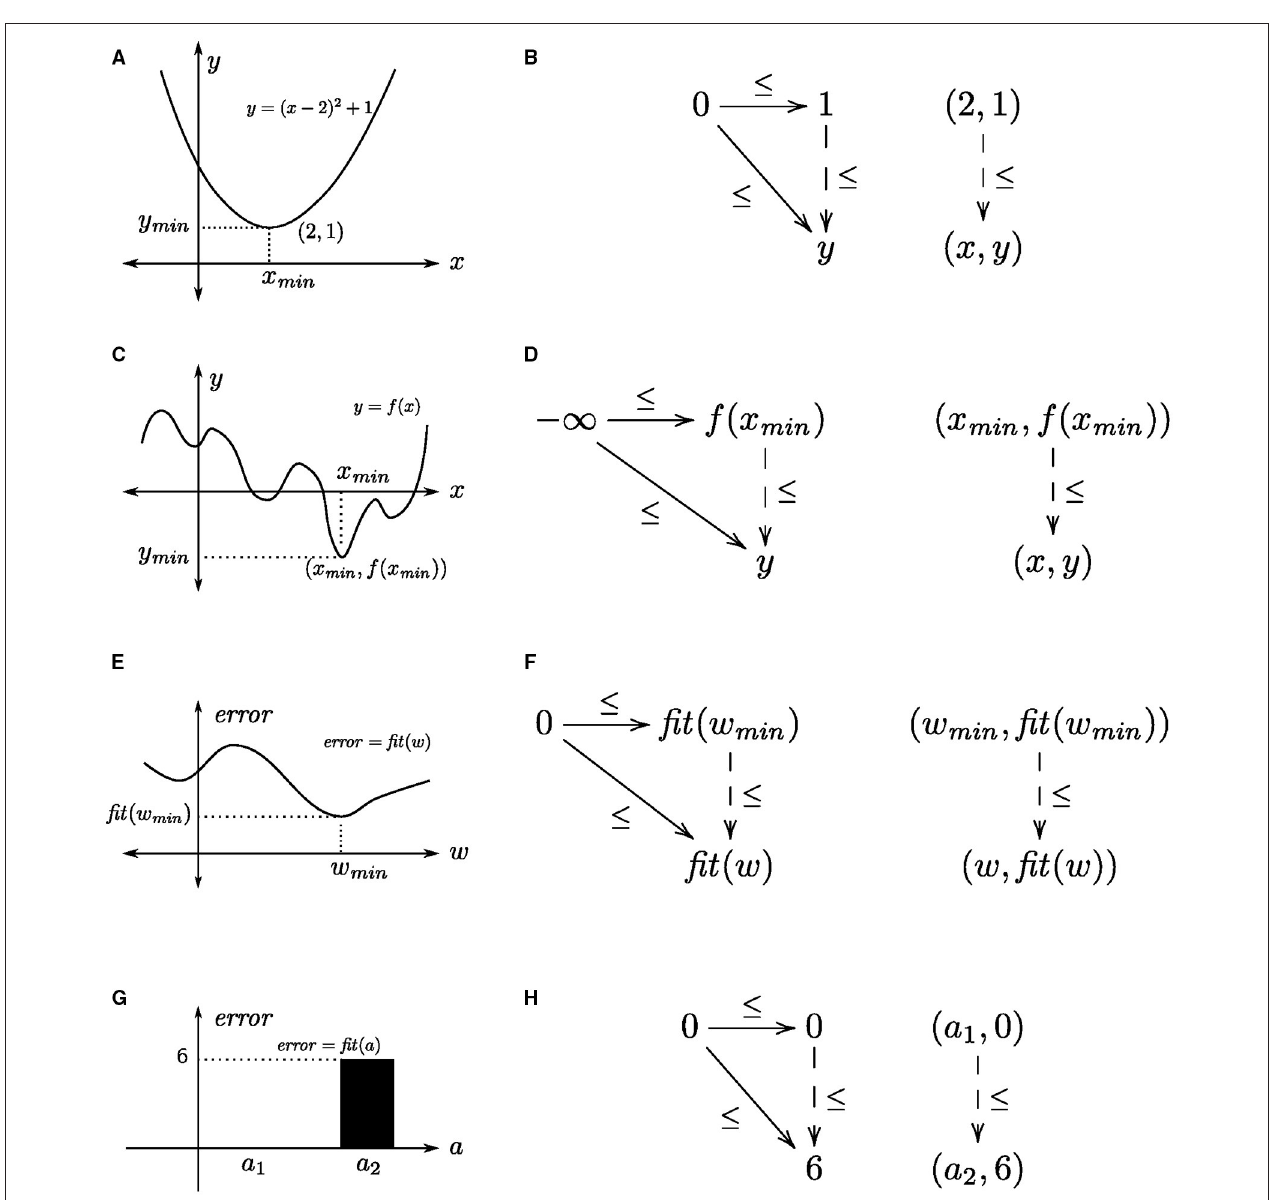
FIGURE 3 | Function minimization as a universal construction. Within each row, the left panel shows the function and the right panel shows the corresponding universal construction. (A,B) a quadratic function, (C,D) an arbitrary function, (E,F) a fitness/error function over network connection weights, and (G,H) a generalized fitness/error function over a collection of